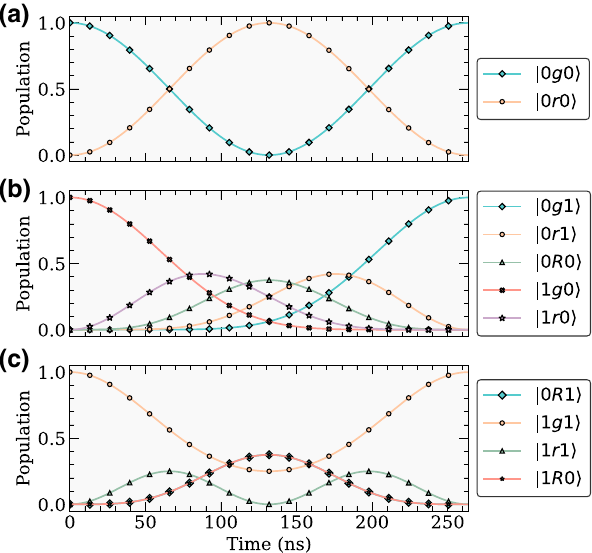
FIG. 2. Population evolution through the driven exchange gate, starting in (a) | 0 g 0 (cid:2) , (b) | 1 g 0 (cid:2) , and (c) | 1 g 1 (cid:2) for (cid:7) = √ 2 / 3 V MR / (cid:2) . While molecule-molecule interaction is included in the evolution, we note that d r (cid:5) d m , such that it only introduces a perturbation to the molecule-Rydberg interaction of magnitude < 10 − 9 . | 0 R 1 (cid:2) and | 1 R 0 (cid:2) states that has no matrix element with the | 1 g 1 (cid:2) ground state. Thus, no excitation is allowed and